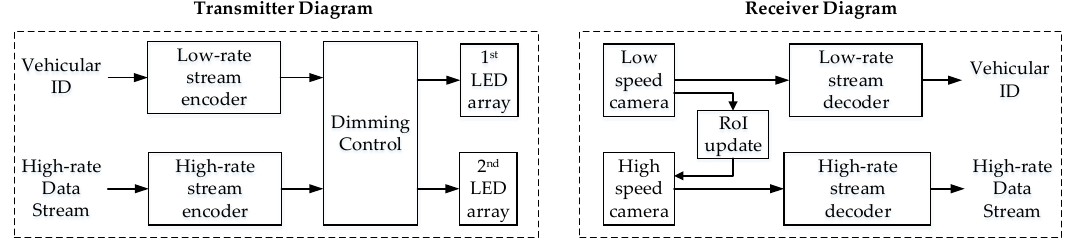
Figure 2. Reference architecture of the region-of-interest (RoI) signaling system employing DS8- PSK.